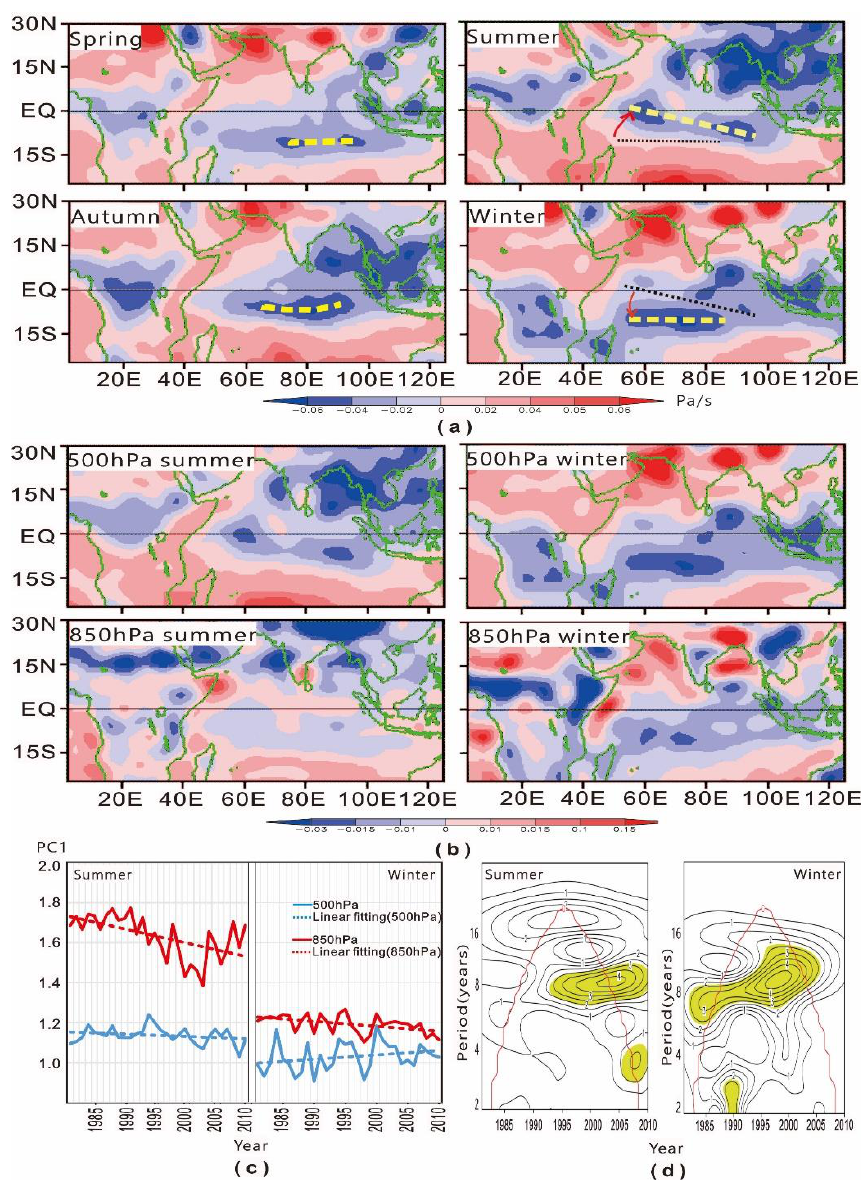
Figure 1. Distribution of the vertical velocity of air over the Indian Ocean. ( a ) Vertical velocity at 500 (December–February). The yellow line delineates the central axis of upward motion. ( b ) Spatial distribution of the primary EOF-analyzed pattern for the vertical velocity at 500 and 850 hPa in summer and winter; all values passed North’s significance test. ( c ) Temporal variation in the primary pattern of the vertical velocities at 500 and 850 hPa in summer and winter. ( d ) Wavelet power spectrum of the temporal coefficients of the primary pattern of the vertical velocity at 500 hPa in both summer and winter. The red line delineates the cone of influence and the yellow areas show confidence levels > 95%.